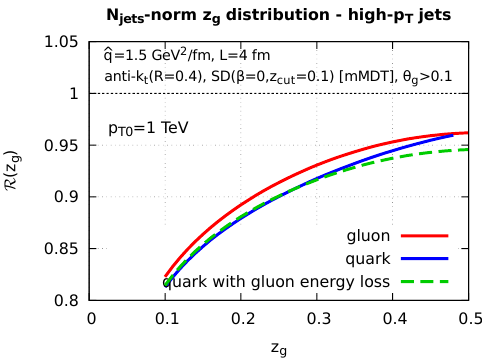
Figure 13 . The results of the analytic calculations for the medium/vacuum ratio R ( z g ) for both gluon- and quark-initiated jets, together with the (cid:12)ctitious case where a quark-initiated subjet loses the same amount of energy as a gluon-initiated